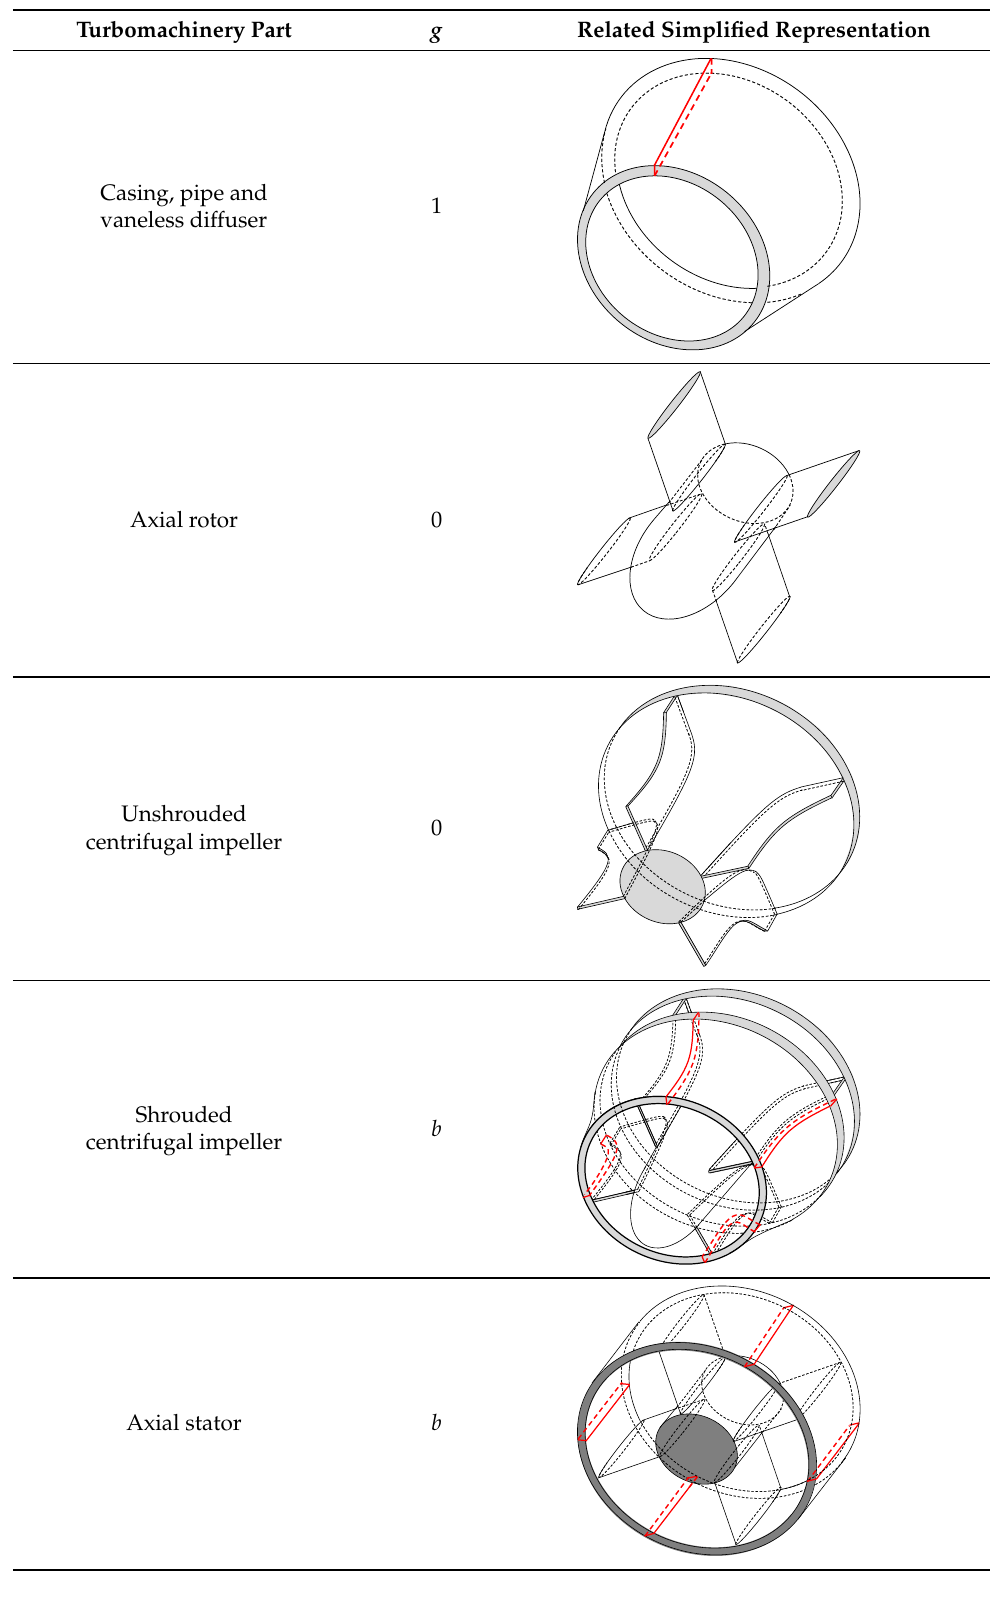
Table 1. Genus of some classical surfaces in